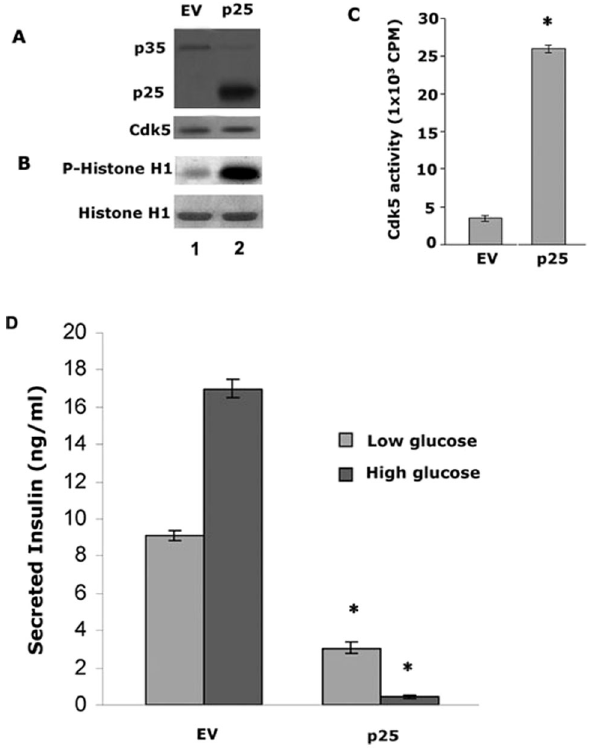
Figure 3. Min6 cells infected with p25, display high levels of Cdk5 activity and inhibits insulin secretion. A Expressions of infected p25 (panel 1, Lane 2) and endogenous p35 (panel 1, lanes 1 and 2) and Cdk5 (panel 2 lanes 1 and 2). B Autoradiograph of phosphorylated histone H1 in infected Min6 cells. The same cell lysates were used for the kinase assay using Cdk5 immunoprecipitates. C Quantification of Cdk5 activities in infected Min6 cells. Data represent mean 6 SE of three experiments. D Insulin secretion was extremely inhibited when p25 were overexpressed in Min6 cells. Insulin released from p25 infected cells was dramatically inhibited under basal and stimulated conditions, more than 95% in the latter case, (* P , 0.01). Data represent mean 6 standard error of three